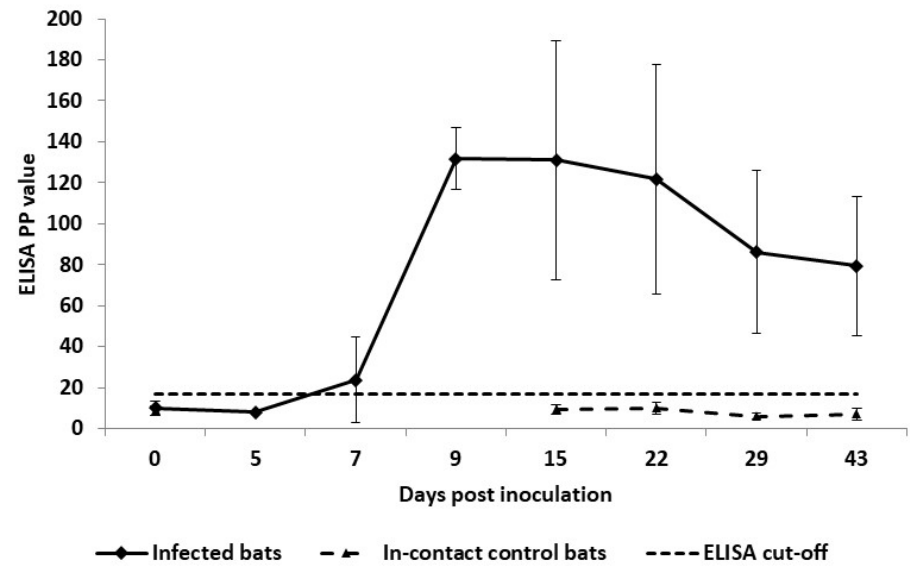
Figure 10. Mean IgG antibody levels (with standard deviations) in Egyptian fruit bats inoculated subcutaneously with Marburg virus (MARV) and in ‐ contact MARV ‐ seronegative bats artificially infested with bat flies. Results for anti ‐ MARV IgG antibody by enzyme ‐ linked immunosorbent assay (ELISA) are shown as the percentage positivity (PP) relative to positive internal control serum; the dotted line without markers denotes an ELISA cut ‐ off value of 16.78 PP [28]. All bats in C1–C6 became viremic within 3–5 days post inoculation (PI), with a mean (±SD) peak viremia of 10 4.6 ± 0.61 TCID 50 /mL on day 5 PI; most bats cleared detectable viremia by day 9 PI (Table 4). At the peak of viremias, there was no statistical difference ( p = 0.260)